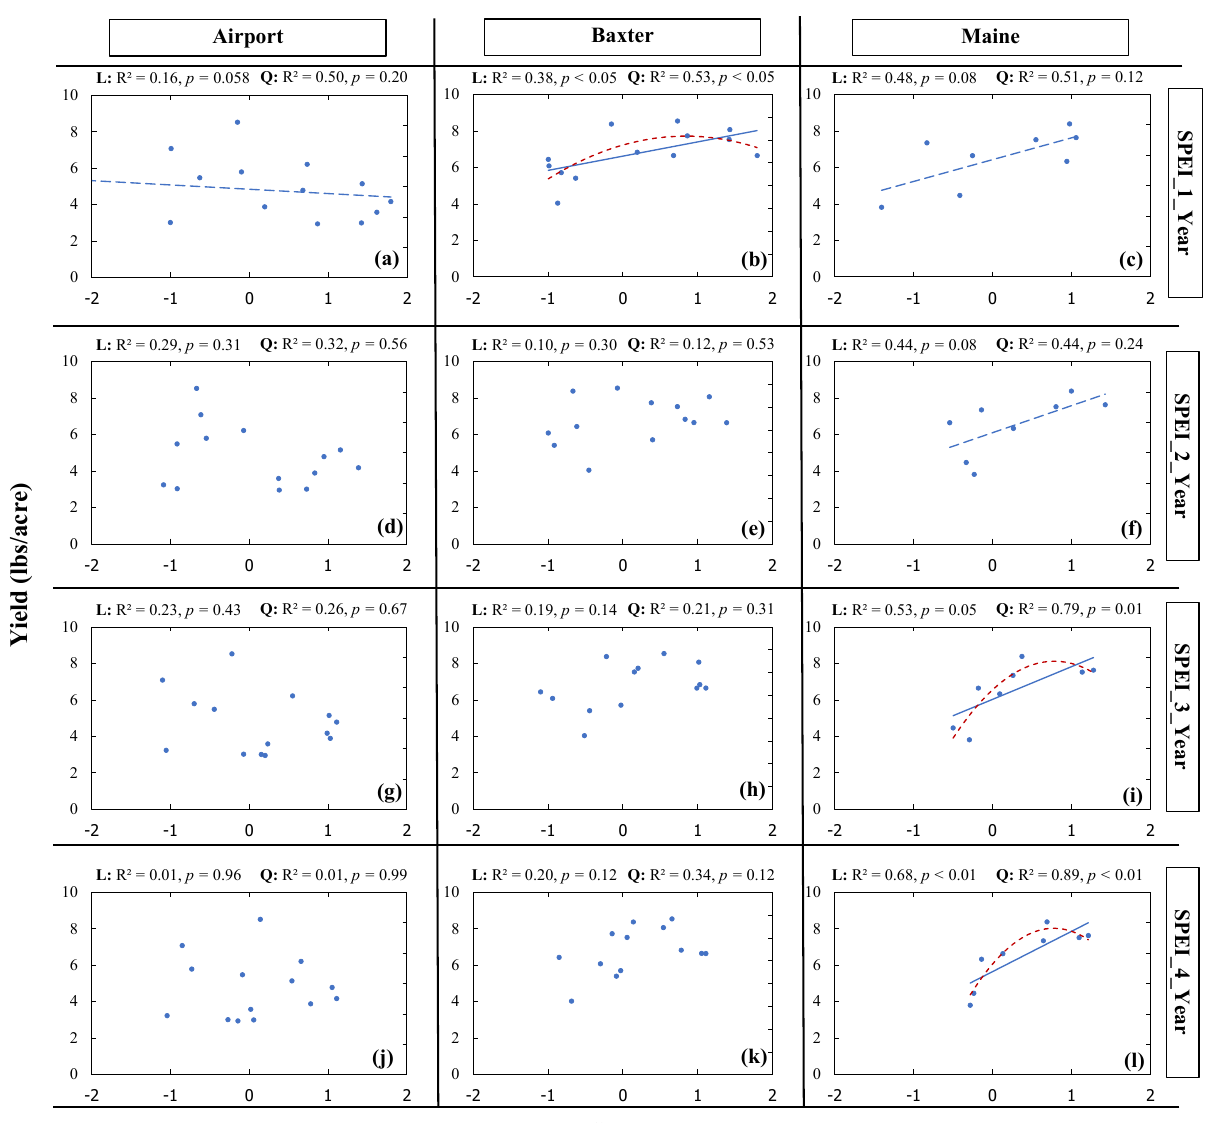
Figure 8. Average yield (lbs./acre) in a year for three different study zones: Airport, Baxter, and the major wild blueberry production region in Maine in relation to ( a – c ) SPEI_1_Year; ( d – f ) SPEI_2_Years (average SPEI of two consecutive years); ( g – i ) SPEI_3_Years (average SPEI of three consecutive years); ( j – l ) SPEI_4_Years (average of SPEI of four consecutive years). The SPEI data represent SPEI_6 of September. Here, SPEI refers to SPEI_6 of September and it represents the SPEI (water conditions) of the growing season (April–September). A positive SPEI value represents wet conditions, while a negative SPEI value indicates dry conditions. The numbers mentioned in the Y -axis were shortened by dividing the yield (lbs./acre) by 1000. The blue solid lines indicate significant ( p < 0.05) and blue dashed lines indicate marginally significant ( p < 0.10) linear relationships. The dashed red lines indicate significant ( p < 0.05) or marginally significant ( p < 0.10) quad- ratic relationships. The time period of the EVI and SPEI data was from 2000 to 2020.